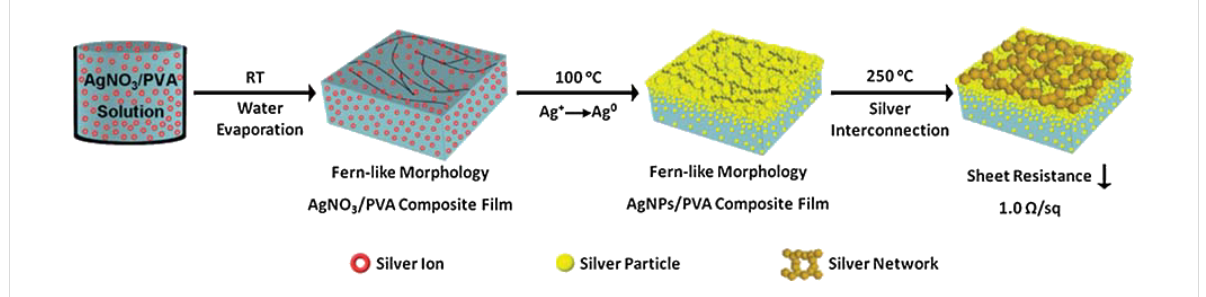
Figure 7: Silver-based transparent conductive films obtained through solvent evaporation, formation of the AgNO 3 /PVA hybrids with a fern-like mor- phology, and silver interconnection via annealing. Reprinted with permission from [134], copyright 2014 Royal Society of Chemistry.